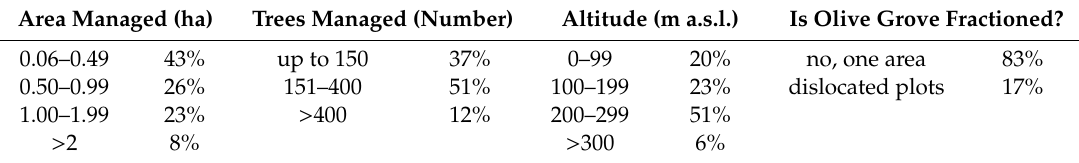
Table 5. Farm characteristics of hobby farmers sample ( n = 35); % refers to the total per item. Area Managed (ha) Trees Managed (Number) Altitude (m a.s.l.) Is Olive Grove